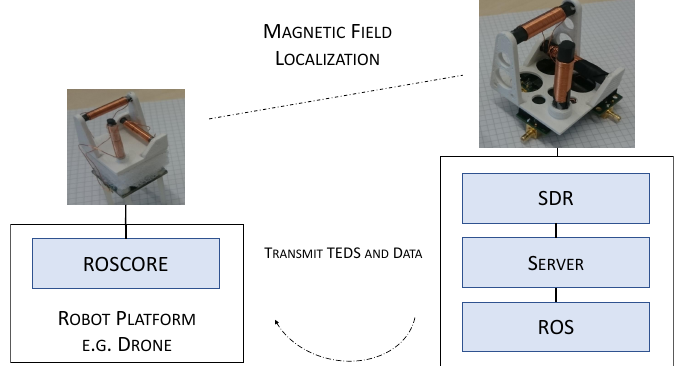
Figure 1. Left is the schematic of the mobile system equipped with a smaller coil setup. Right is the artificial landmark station with a static pose and holds a larger coil system. On the side of the landmark, the coil system is connected to an SDR platform for further signal